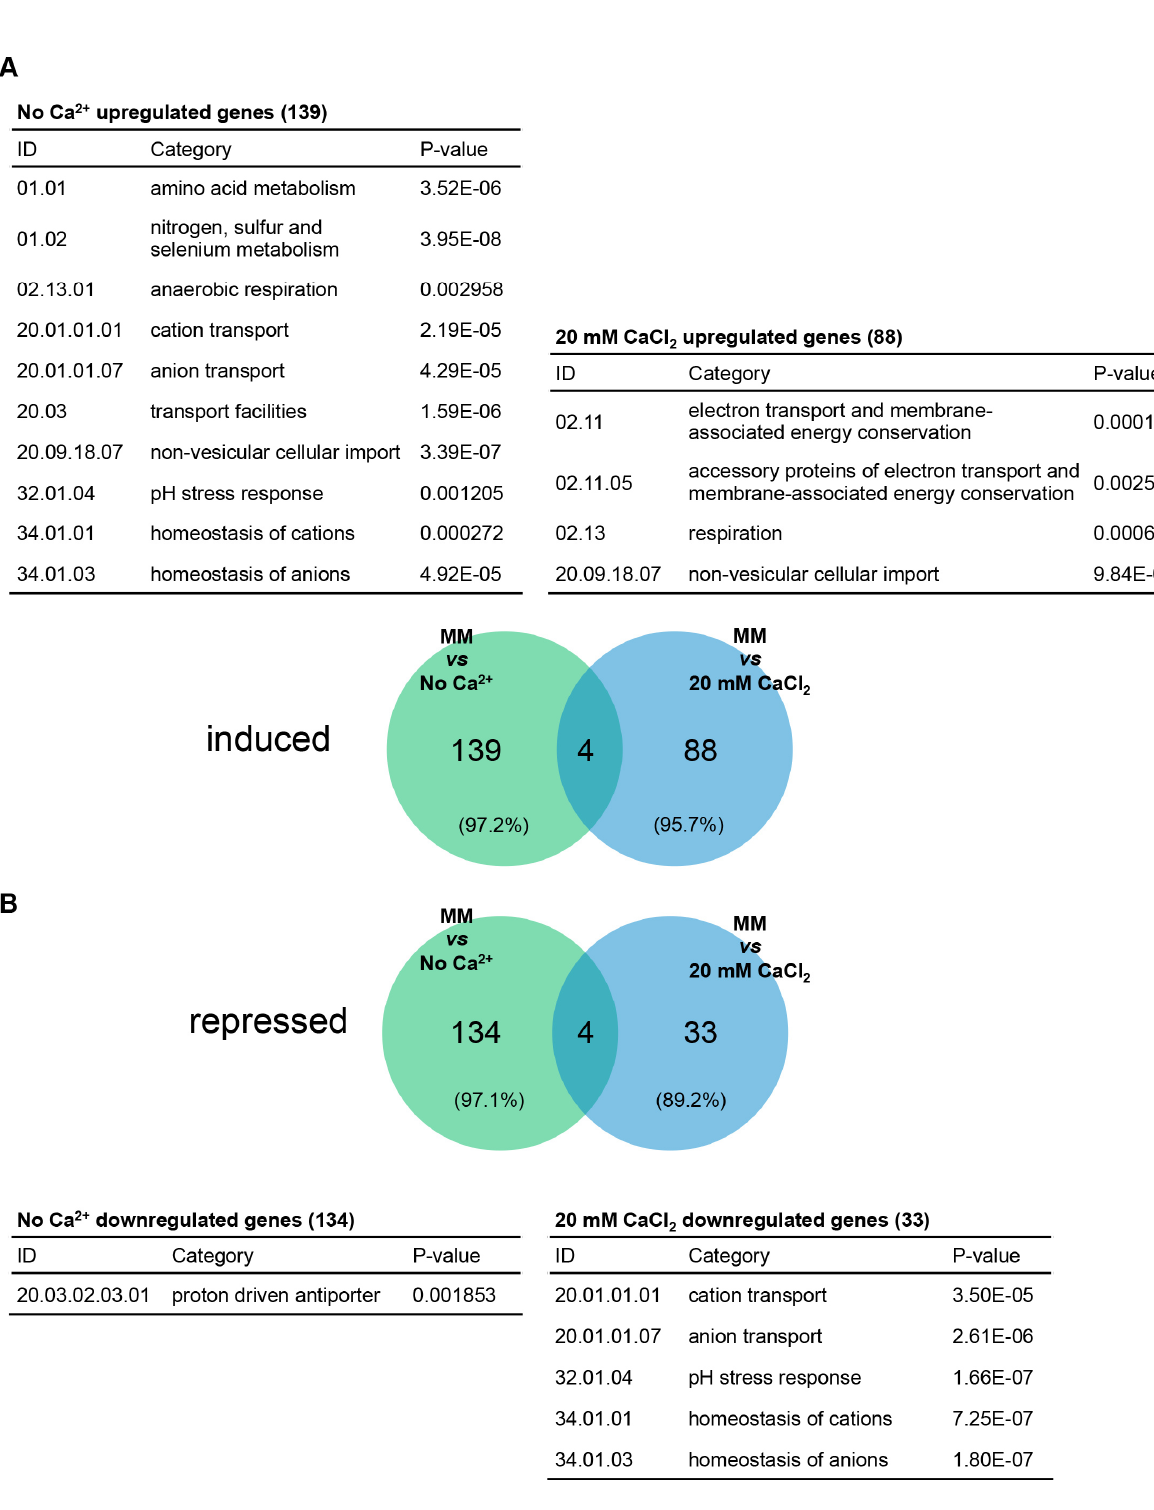
OPEN ACCESS | www.microbialcell.com 294 Microbial Cell | September 2014 | Vol. 1 No. 9